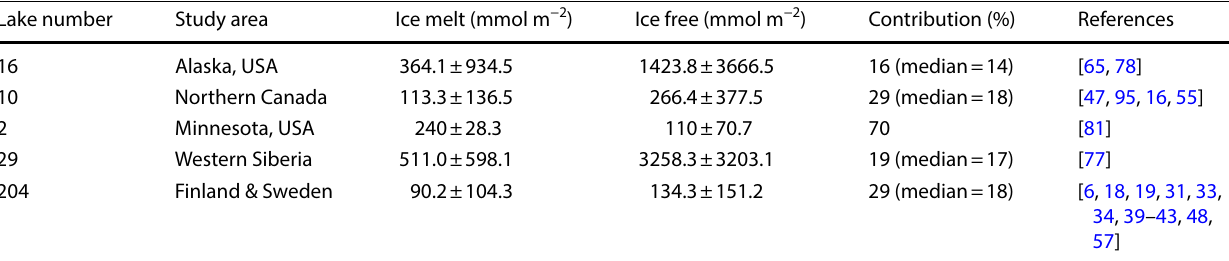
sion to annual emission expressed as mean and median values. The Table 1 Northern lakes’ CH emissions at ice-melt and ice-free peri- 4 ebullition flux is not ods from different study areas expressed as average ± standard deviation, and the percentage contribution of ice-melt CH emis- 4